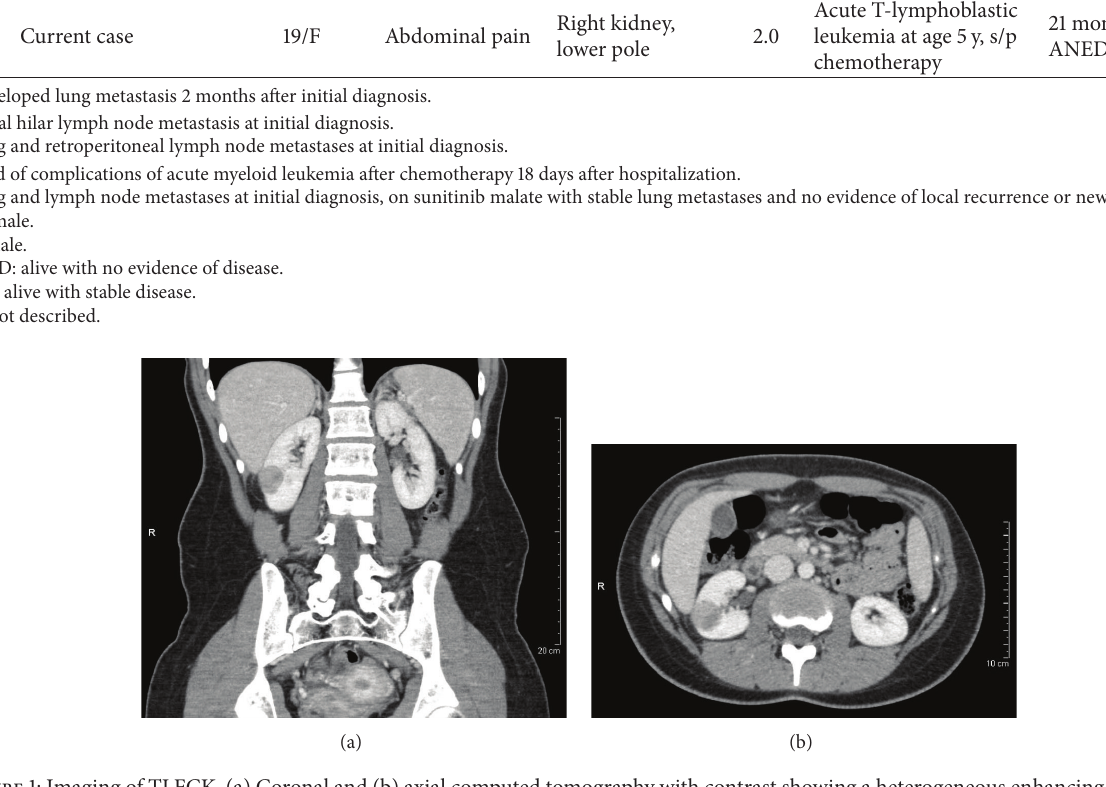
Figure 1: Imaging of TLFCK. (a) Coronal and (b) axial computed tomography with contrast showing a heterogeneous enhancing right renal